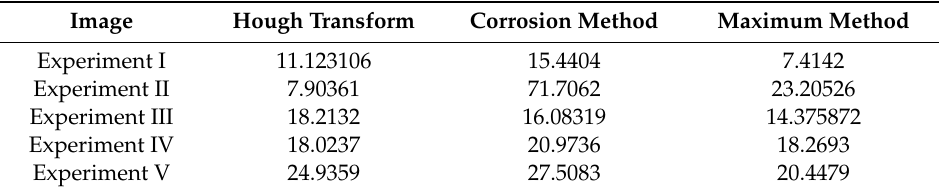
Table 2. Apple’s center errors.